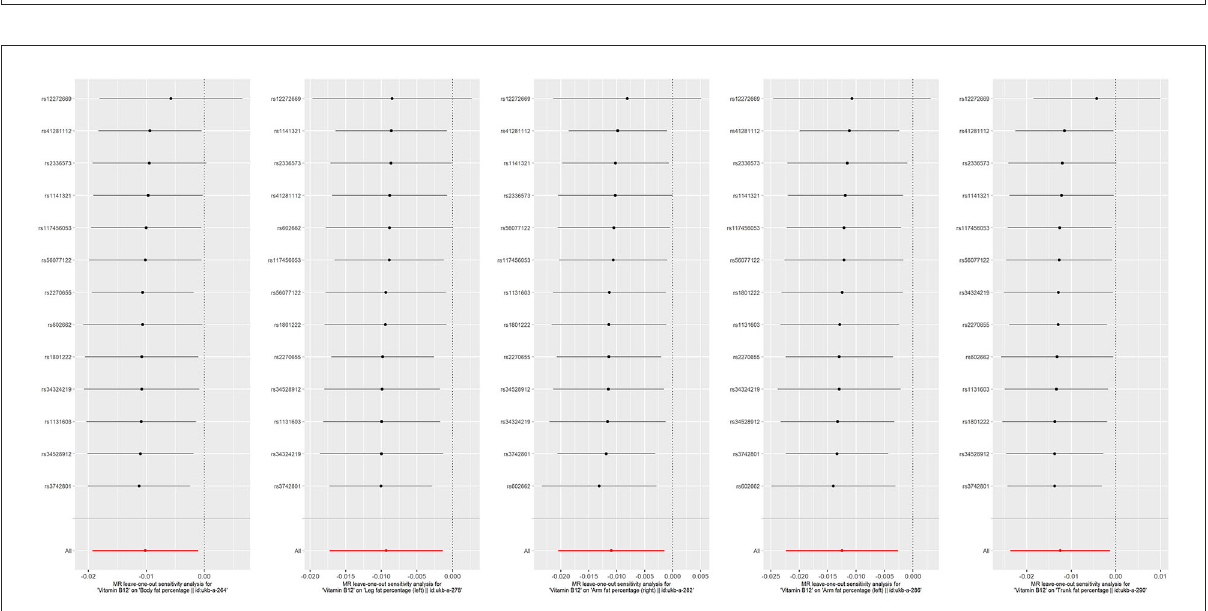
FIGURE7 Forest plot for leave-one-out analysis of the significant IVW results of vitamin B12 with fat percentage, with each point denoting the causal effect by IVW after removing the specific SNP on the left side. IVW, inverse variance weighted method.